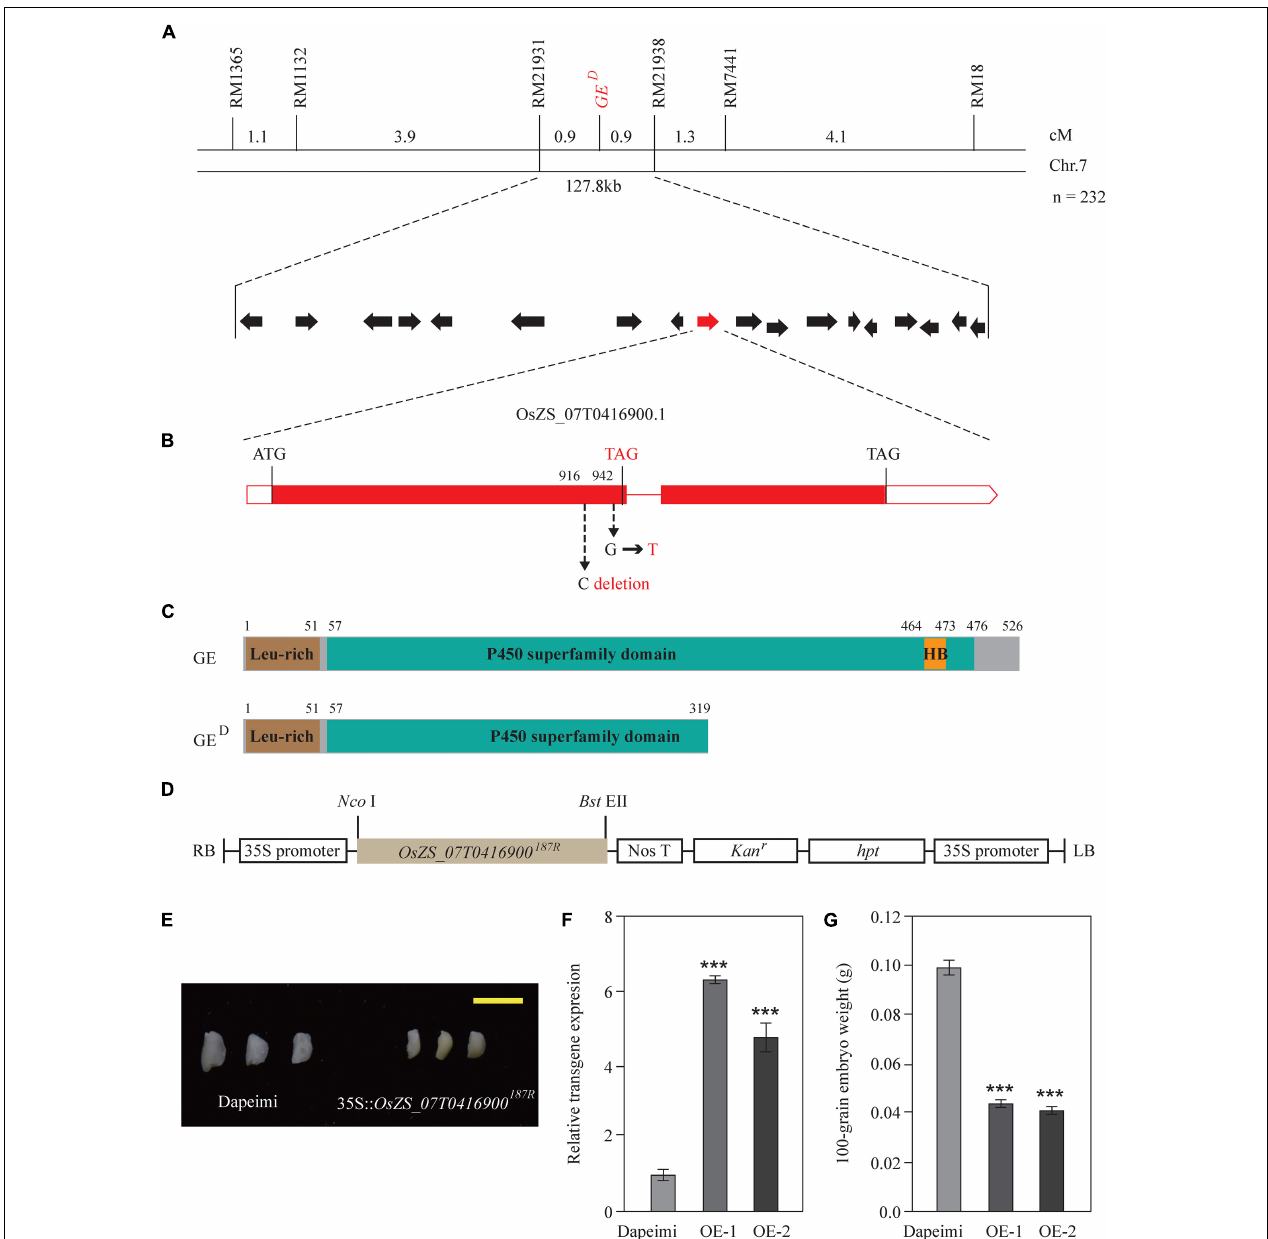
FIGURE 2 | Map-based cloning and confirmation of the GE D gene. (A) Gene location was performed with 232 giant embryo plants in the F 3 families. Genetic distance between adjacent markers is indicated above the linkage map. GE D locus was narrowed down to a 127.8-kb interval between the SSR marker RM21931 and RM21938 on chromosome 7. This region contains 18 predicated genes. (B) Gene structure and allelic variations of OsZS_07T0416900 between 187R and Dapeimi. Filled boxes and red lines represent exons and introns, respectively. Start and stop codons are indicated above the gene, and allelic variations and a premature stop codon are shown in red letters. 187R was used as the reference for allelic comparison. (C) Comparison of protein structure between GE and GE D . Start and stop positions of each domain are indicated above the protein. (D) The basic structure of the expression vector pCaMV35S: OsZS_07T0416900 187R